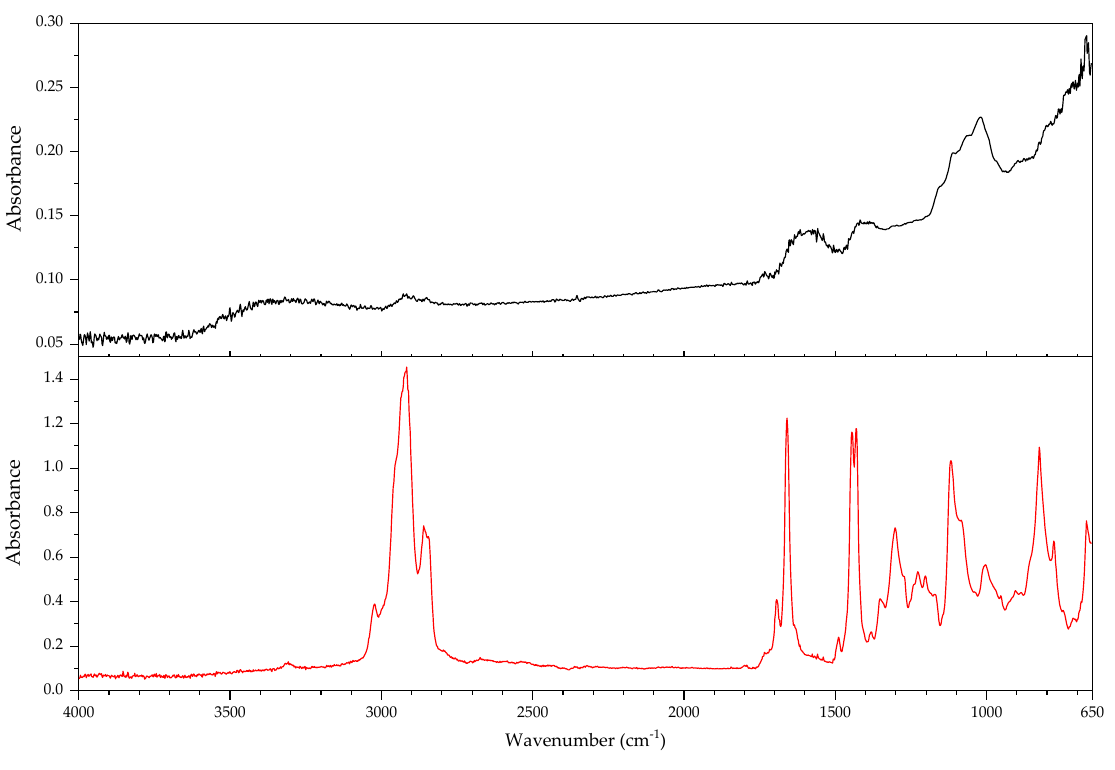
Figure 18. FTIR spectrum of sample 530 (black line) compared to reference spectrum of polychloro- prene (red line) from a commercial database.